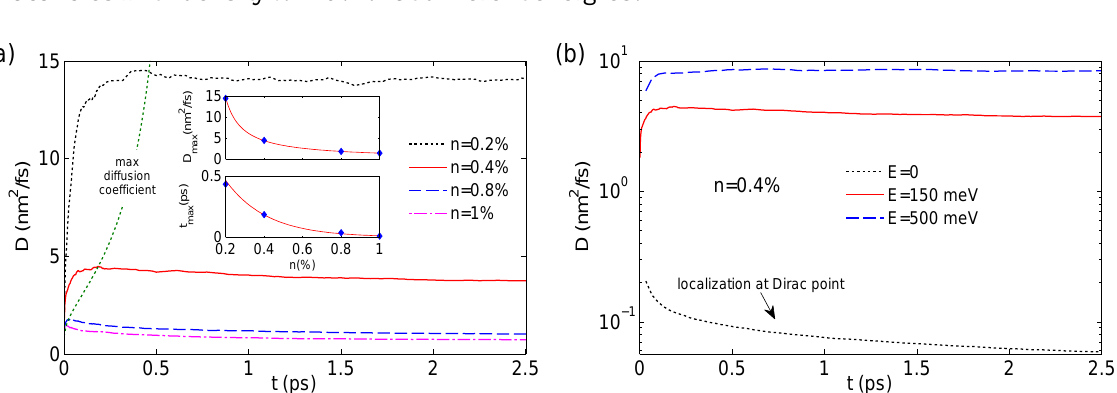
Figure 6. ( a ) Main frame: Diffusion coefficient as a function of time for electrons with energy E = 150 meV in graphene with different densities of compensated vacancies. The position of the maximum diffusion coefficient is indicated by a dashed line. Top inset: Maximum diffusion coefficient as a function of the vacancy density. The solid line is a guide to the eye. Bottom inset: Time corresponding to the maximum diffusion coefficient. The solid line is a guide to the eye; ( b ) Diffusion coefficient as a function of time for compensated vacancies with density n = 0.4% at different energies.